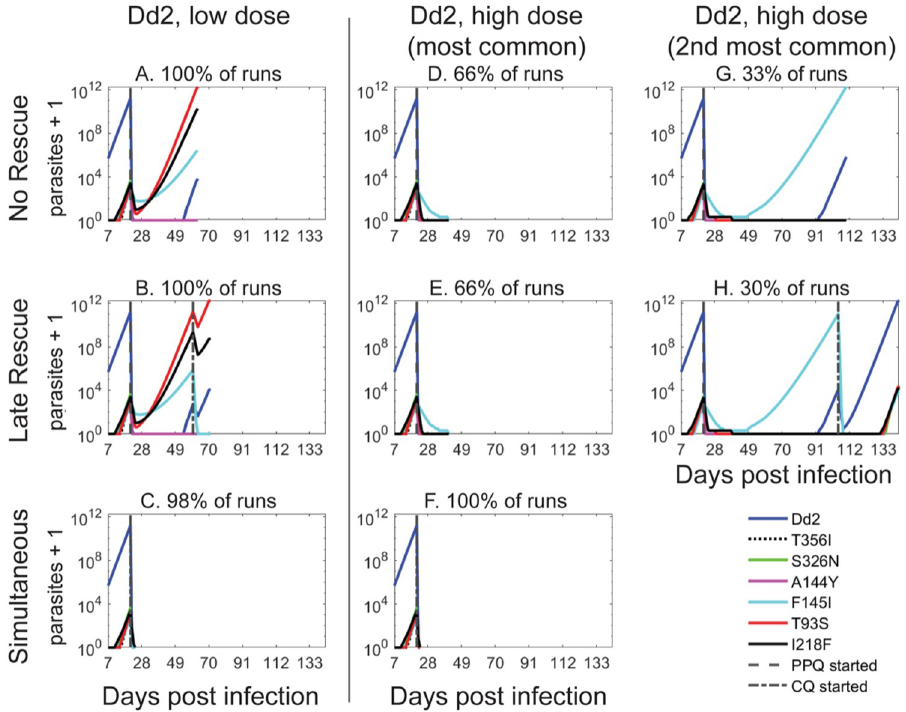
Fig 6. Evolutionary simulations with Dd2 parasites demonstrate that high-dose PPQ plus CQ can clear infections and prevent the emergence of drug-resistant variants. Representative simulation results starting with infection by a monoculture of PPQ-sensitive Dd2 Dd2 parasites followed by initial treatment with a low-dose regimen of 200 nM PPQ as ( A ) monotherapy; ( B ) plus late rescue with 125 nM CQ; or ( C ) simultaneous PPQ and CQ treatment. Representative simulation results starting with Dd2 Dd2 parasites followed by initial treatment with a high-dose regimen of 400 nM PPQ as ( D, G ) monotherapy; ( E, H ) plus late rescue with 250 nM CQ; or ( F ) simultaneous PPQ and CQ treatment. Panels D, E, F show the most common outcome in 100 stochastic simulations of each treatment regimen. Panels B, D show the next most common outcome (summarized in Table 2 ). 100 stochastic simulations were run for each condition, with the percentage frequencies listed for particular outcomes. Dashed vertical lines indicate initiation of each three-day dosing.